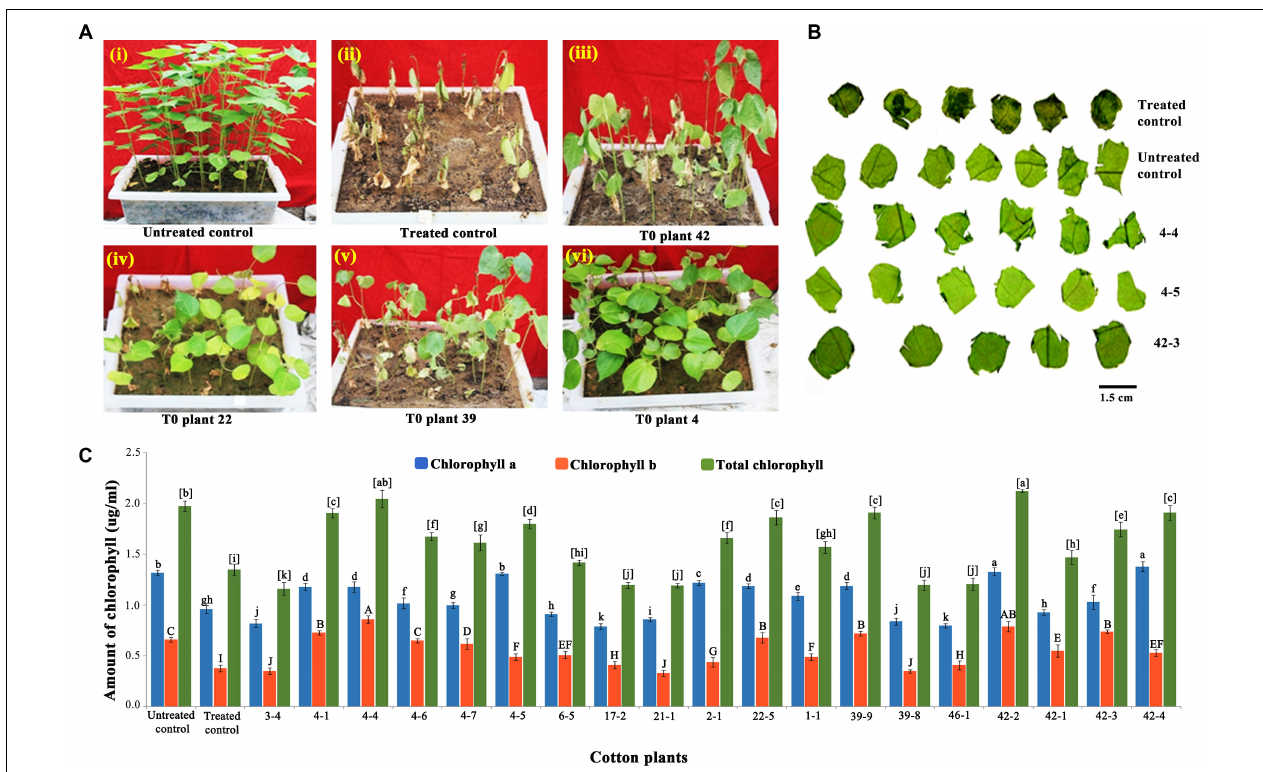
FIGURE 3 | Glyphosate tolerance assays for the identification of putative transformants. (A) Seedling level screening: T1 generation and wild-type seedlings were sprayed with 800 mg/L glyphosate (i) untreated control, (ii) treated control, (iii–vi) representative trays containing putative transformants. (B) Plant level screening: Response of leaf discs of 45-day-old representative transgenic and wild-type plants to 1,500 mg/L glyphosate. (C) Estimation of chlorophyll in the glyphosate treated transgenic plants vis-à-vis wild